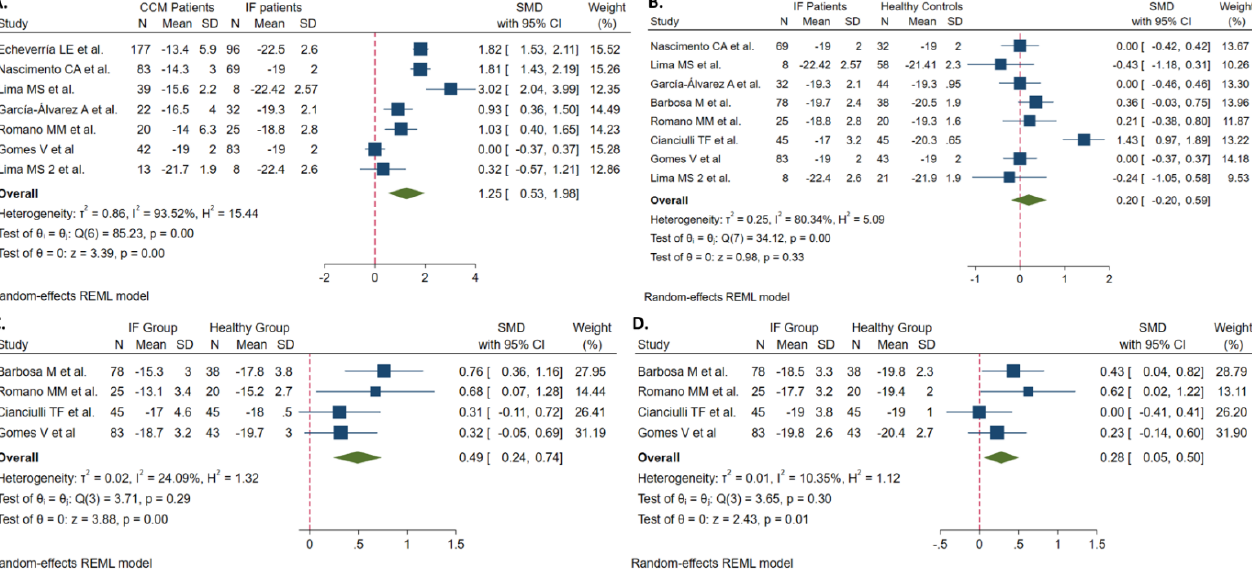
Figure 4. Forest plots evaluating the differences in ( A ) global longitudinal strain between CCM and IF patients, ( B ) global longitudinal strain between IF patients and controls, ( C ) basal-inferoseptal strain, and ( D ) mid-inferoseptal strain between IF patients and controls.